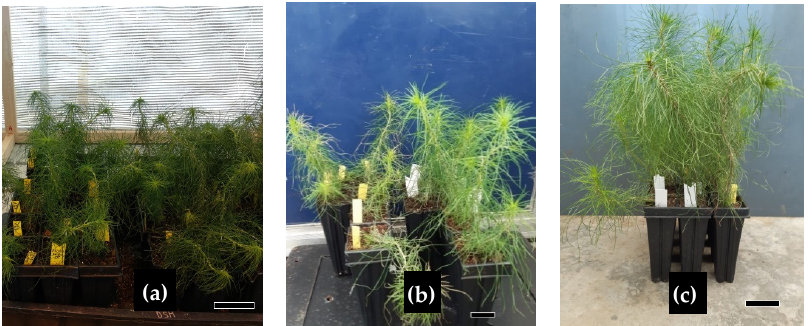
Figure 7. Pinus radiata D.Don somatic plants: ( a ) showing needle epinasty and apical curvature at greenhouse temperature of 40 °C under irrigation or nonirrigated (left and right, respectively), bar = 6 cm; ( b ) plants not irrigated submitted to 40 and 23 °C in greenhouse (left and right, respectively), bar = 3 cm; ( c ) plants not irrigated submitted to 23 and 40 °C in greenhouse (left and right, respectively), after rewatering, bar = 6 cm. Table 3. Analysis of variance (ANOVA) for the effect of different maturation temperatures (MT) and greenhouse temperatures (GT) on the initial and final water potential ( Ψ leaf initial and Ψ leaf final, respectively) in plants of Pinus radiata D.Don under irrigation and/or no irrigation conditions (I). ANOVA Effect